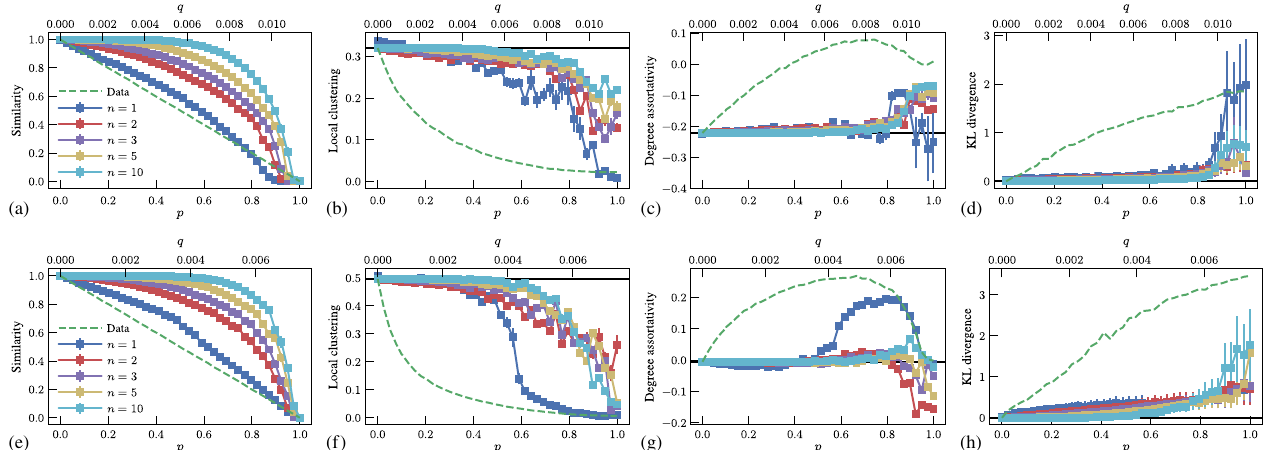
FIG. 4. Reconstruction performance for political blogs (top row) and openflights (bottom row) networks. In each case, the empirical network is considered as the true network, and simulated measurements are made for several values of missing edge probability p , with a − E (cid:2) . (a),(e) Similarity of the MMP estimator to the true network, S ð ˆ A ; A (cid:3) Þ , as a function of p , spurious edge probability q ¼ pE= ½ð N 2 Þ and for several values of the number of repeated measurements, n . (b),(c),(f),(g) Posterior average local clustering and degree assortativity coefficients, according to the same legend as (a) and (e). (d),(g) KL divergence between true and inferred degree distributions, as discussed in the text. In all cases [(a) – (h)], the dashed curve shows the corresponding value obtained directly with the measured data with n ¼ 1 , and the solid horizontal line marks the true value corresponding to perfect reconstruction.